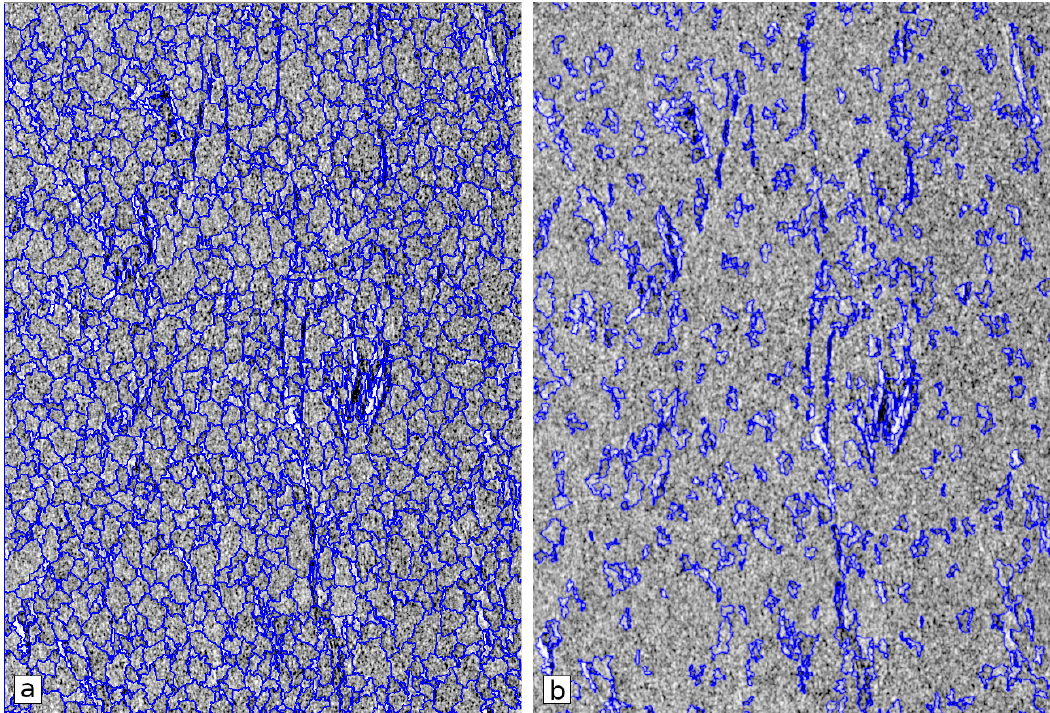
Figure 10. ( a ) Preliminary segmented image after Multiresolution Segmentation (MRS) processing; ( b ) modified result after Spectral Difference Segmentation (SDS).